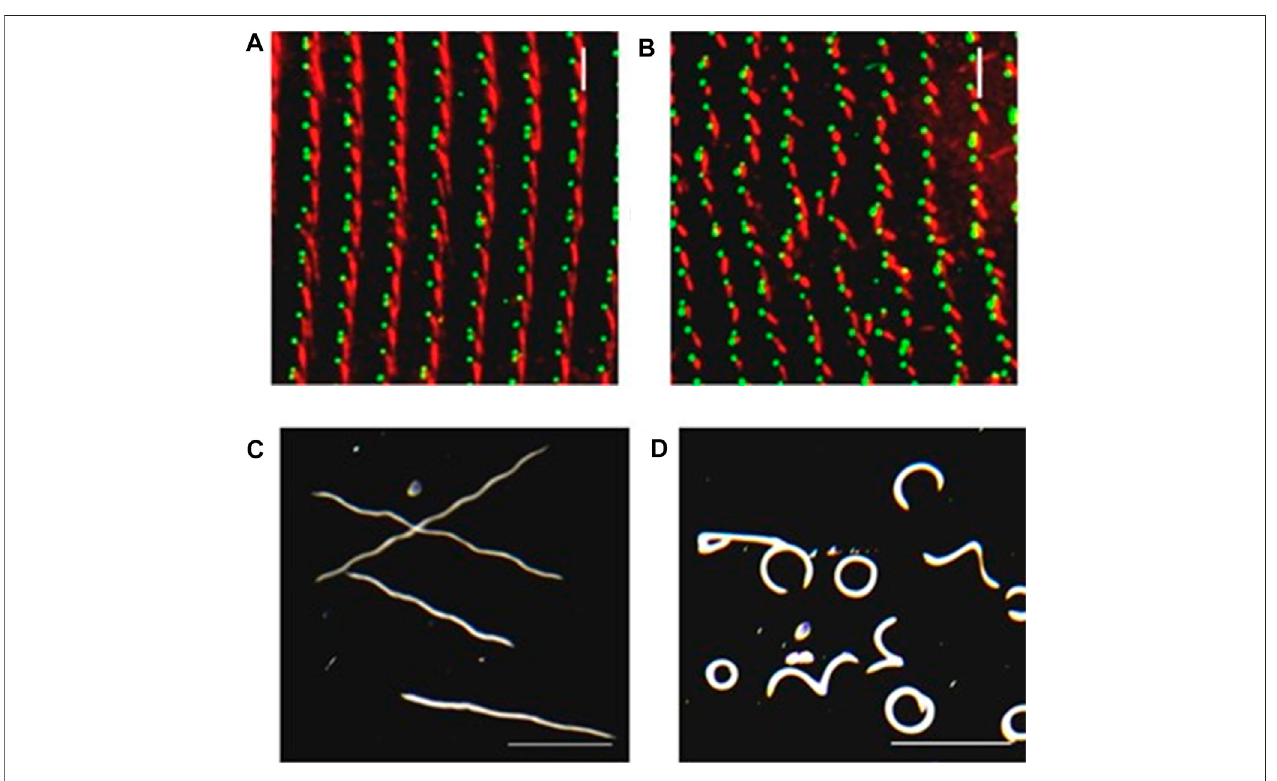
FIGURE 5| Depletion ofSR gene products can lead tobasalbody and row misalignment. (A) Control cell (left) and RNAi treated cell withreduced SR proteins. (B) withbasalbodiesidenti fi edingreenwithID5antibodies,andtheSRsidenti fi edinredwithanti-SRantibody.Notemisalignmentofbasalbodyrowsandmis-orientationof basalbodies. (C) Controlcellsand (D) RNAitreatedcellswithreduced SRproteins asthey swiminapoolofrestingbuffer forthesameperiod oftime.Note thatthemis- orientation of basal bodies and rows leads to abnormal swimming (Nabi et al., 2019).